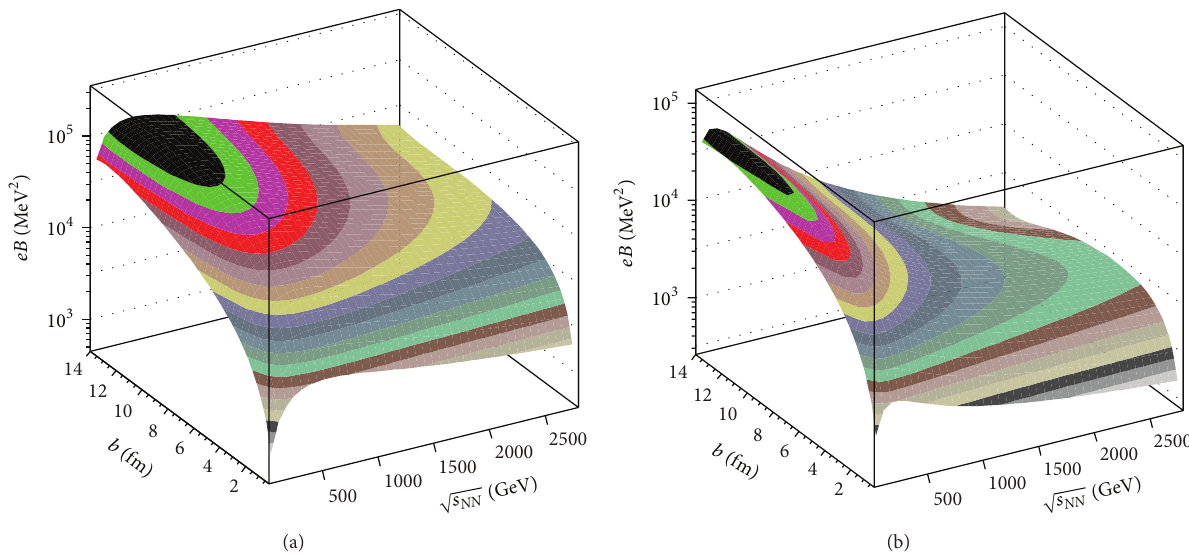
Figure 6: The dependencies of the magnetic field on collision energies of central mass system and impact parameters at different proper times for 𝜏 = 0.02 fm (a) and 𝜏 = 0.05 fm (b).